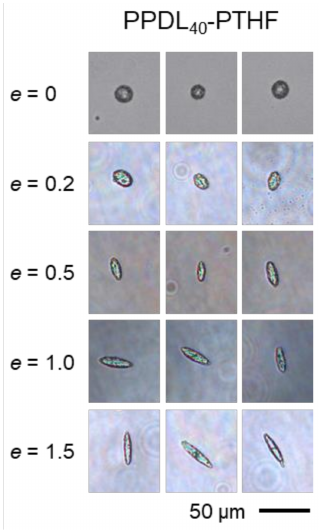
Figure 3. Exemplary light microscopy images for PPDL 40 -PTHF particles before and after deforma- tion. Images were collected in aqueous suspension after isolation by phantom